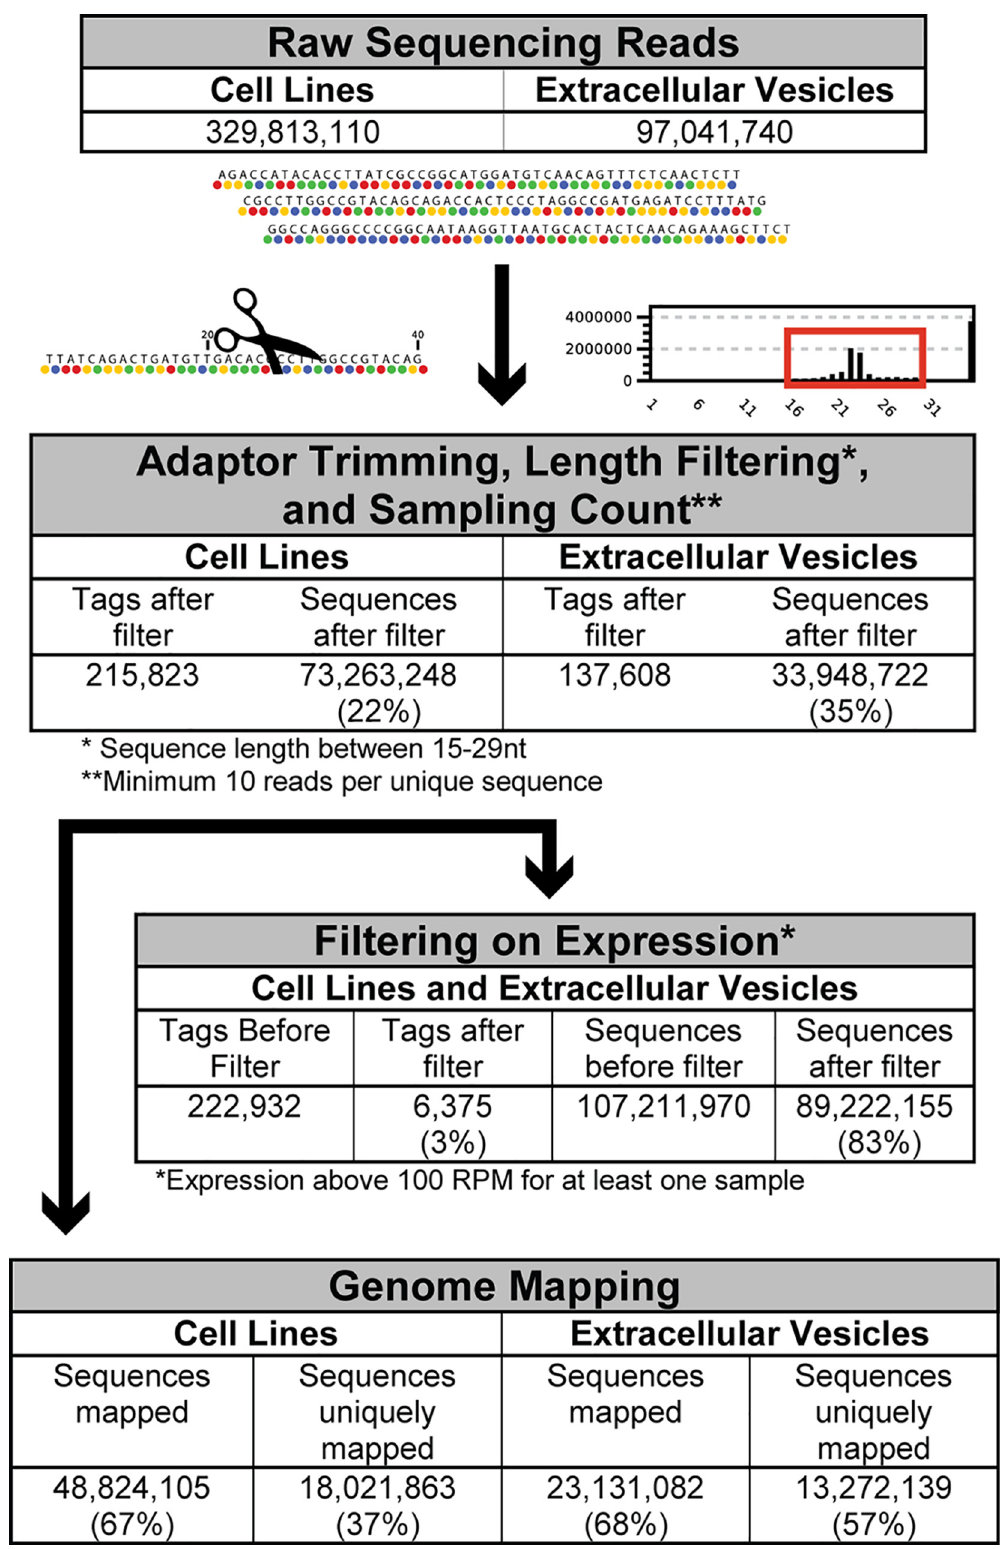
Fig 1. Data analysis pipeline for reads generated from small RNA SOLiD sequencing in the breast cancer cell lines and their corresponding EVs.